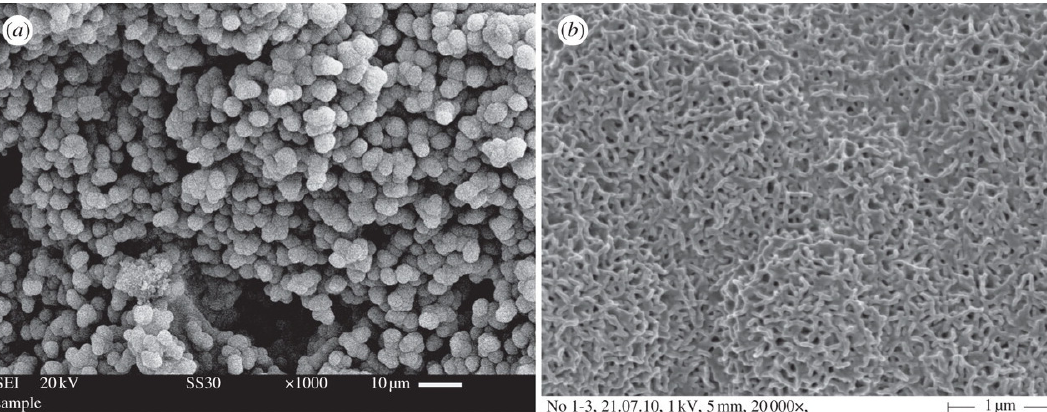
Figure 10. Nano-crystalline apatite mineralization on the surface of three-dimensional MBG scaffolds: ( a ) “cauliflower” globular agglomerates (low magnification image), ( b ) details of nano-crystals (high magnification image) [7].